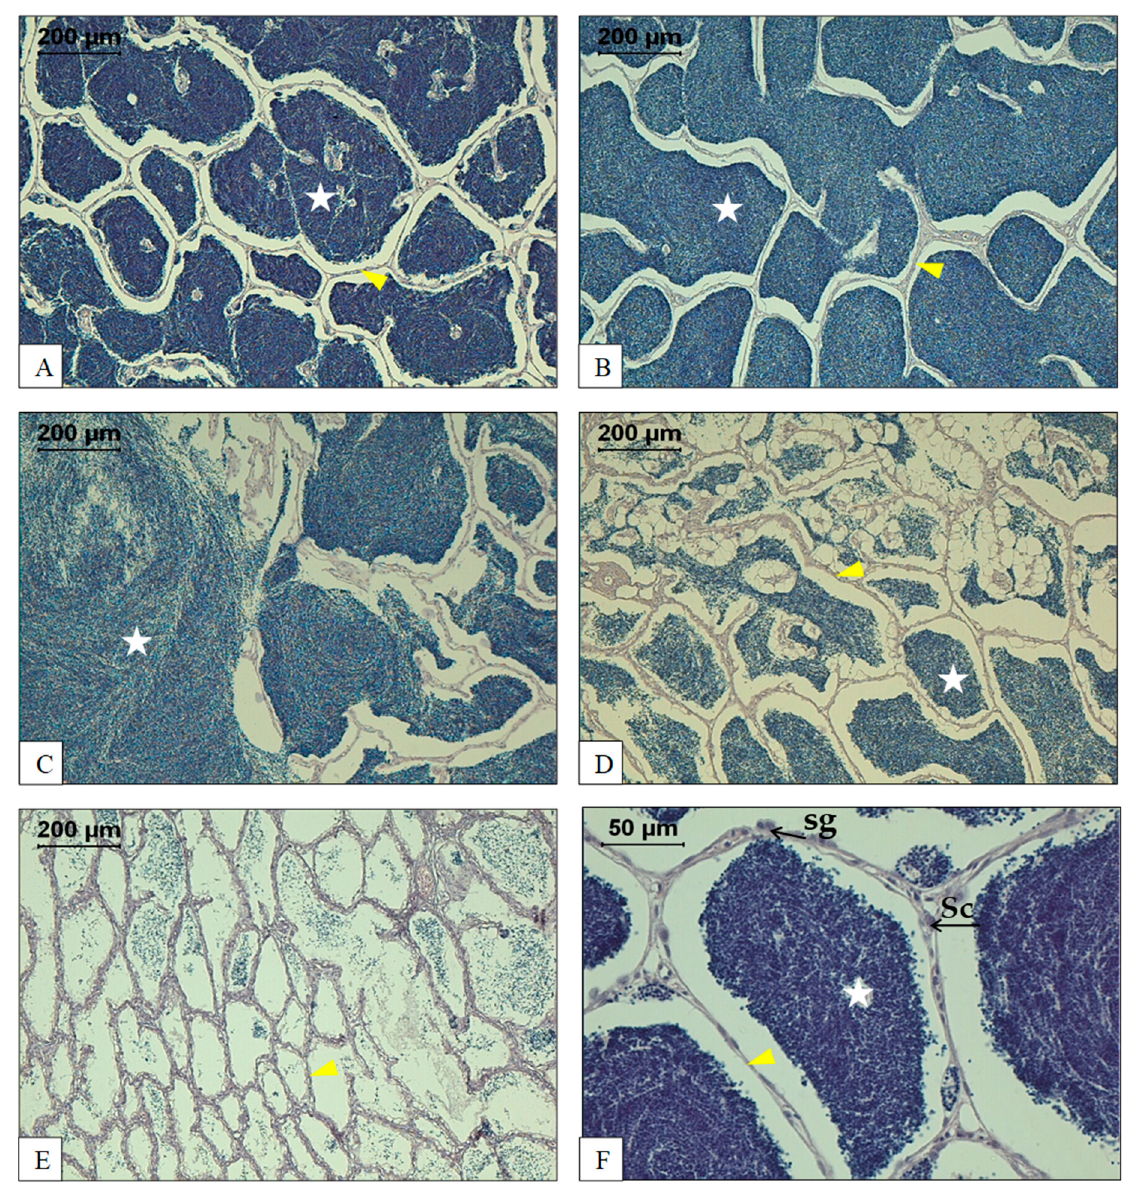
Figure 3. Histological cross-sections of sex-reversed female (SRF) rainbow trout gonads during the spawning season: ( A ) Similar-sized seminiferous tubules at the beginning of the spawning season filled by spermatids and spermatozoa. Ampullae walls separated from the central parts of structures by space isolated from storage within cytological elements; ( B ) tubules with different spatial structures (different sizes), and the walls isolated by the space (gap) between the germ cells located inside the whole tubule structure; ( C ) the unsettled spatial structure of seminiferous tubules during the peak of the spawning season, where part of the walls were perforated and spermatozoa filled most of the available testes space; ( D ) tubules completely or partially free of spermatozoa, which lose their regular shape, and spermatozoa filled all spaces between the interstitial tissue elements, i.e., the walls of the seminiferous tubules; ( E ) seminiferous tubules were mostly empty with an irregular spatial structure at the end of the spawning season. The walls of tubules had increased thickness where a large number of spermatogonia and primary spermatocytes appeared; ( F ) magnification of the single seminiferous tubule filled with spermatids and spermatozoa at the beginning of the spawning season. Description: Seminiferous tubules filled with spermatids and/or spermatozoa (white asterisk); walls of tubules—interstitial tissue (yellow arrowhead); Sc, Sertoli cells; sg, spermatogonia.